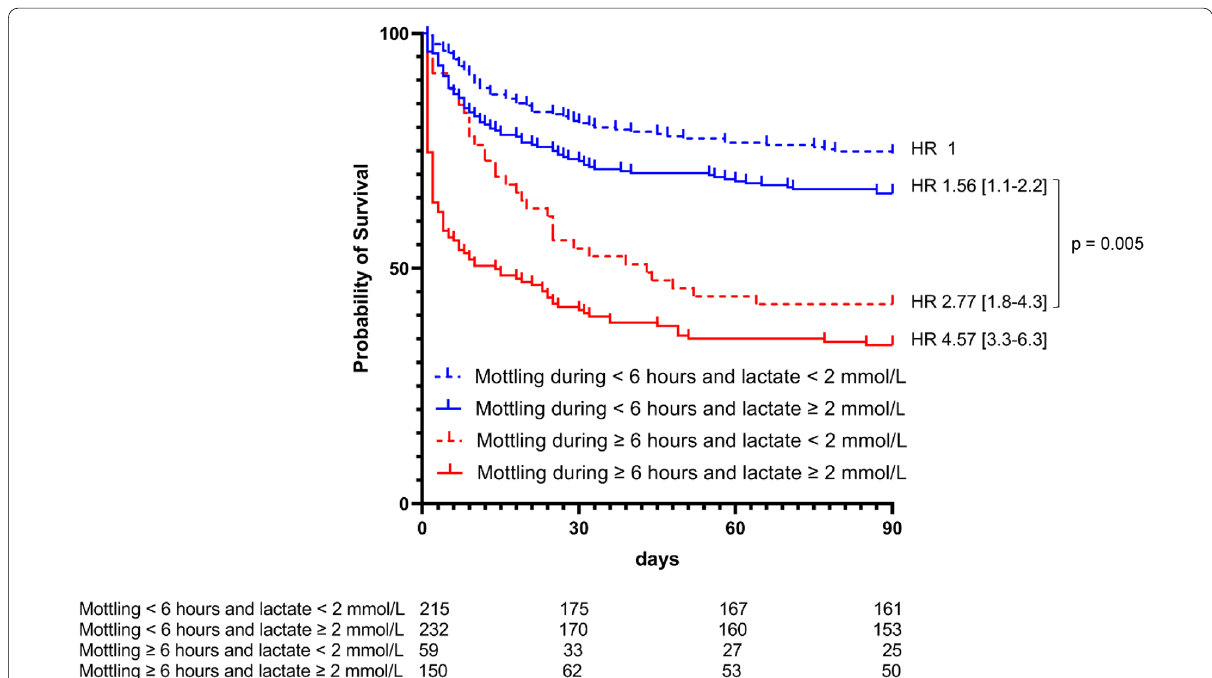
Fig. 5 Survival according to mottling duration during the first 24 h and arterial lactate at inclusion. Kaplan–Meier curves represent the survival according to the duration of mottling and the arterial lactate level. Hazard ratios (HR) were calculated using a Cox model. We defined the group of patients with mottling duration < 6 h during the first 24 h of septic shock and lactate < 2 mmol/L at inclusion as the reference. HR were adjusted on randomization group, age, SAPS II, past medical history (chronic arterial hypertension, myocardial infarction,) and MAP, lactate, fluid intake, vasopressor dose at inclusion and need for mechanical ventilation at inclusion. Patients without mottling or mottling lasting for less than 6 h and with arterial lactate 2 mmol/L had a higher probability of survival than patients with mottling lasting for ≥ ( p =